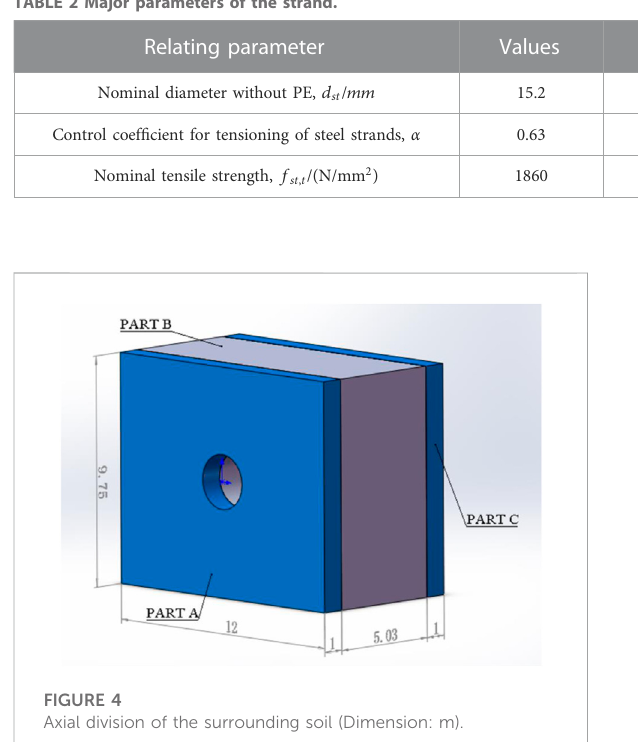
FIGURE 4 Axial division of the surrounding soil (Dimension: m).